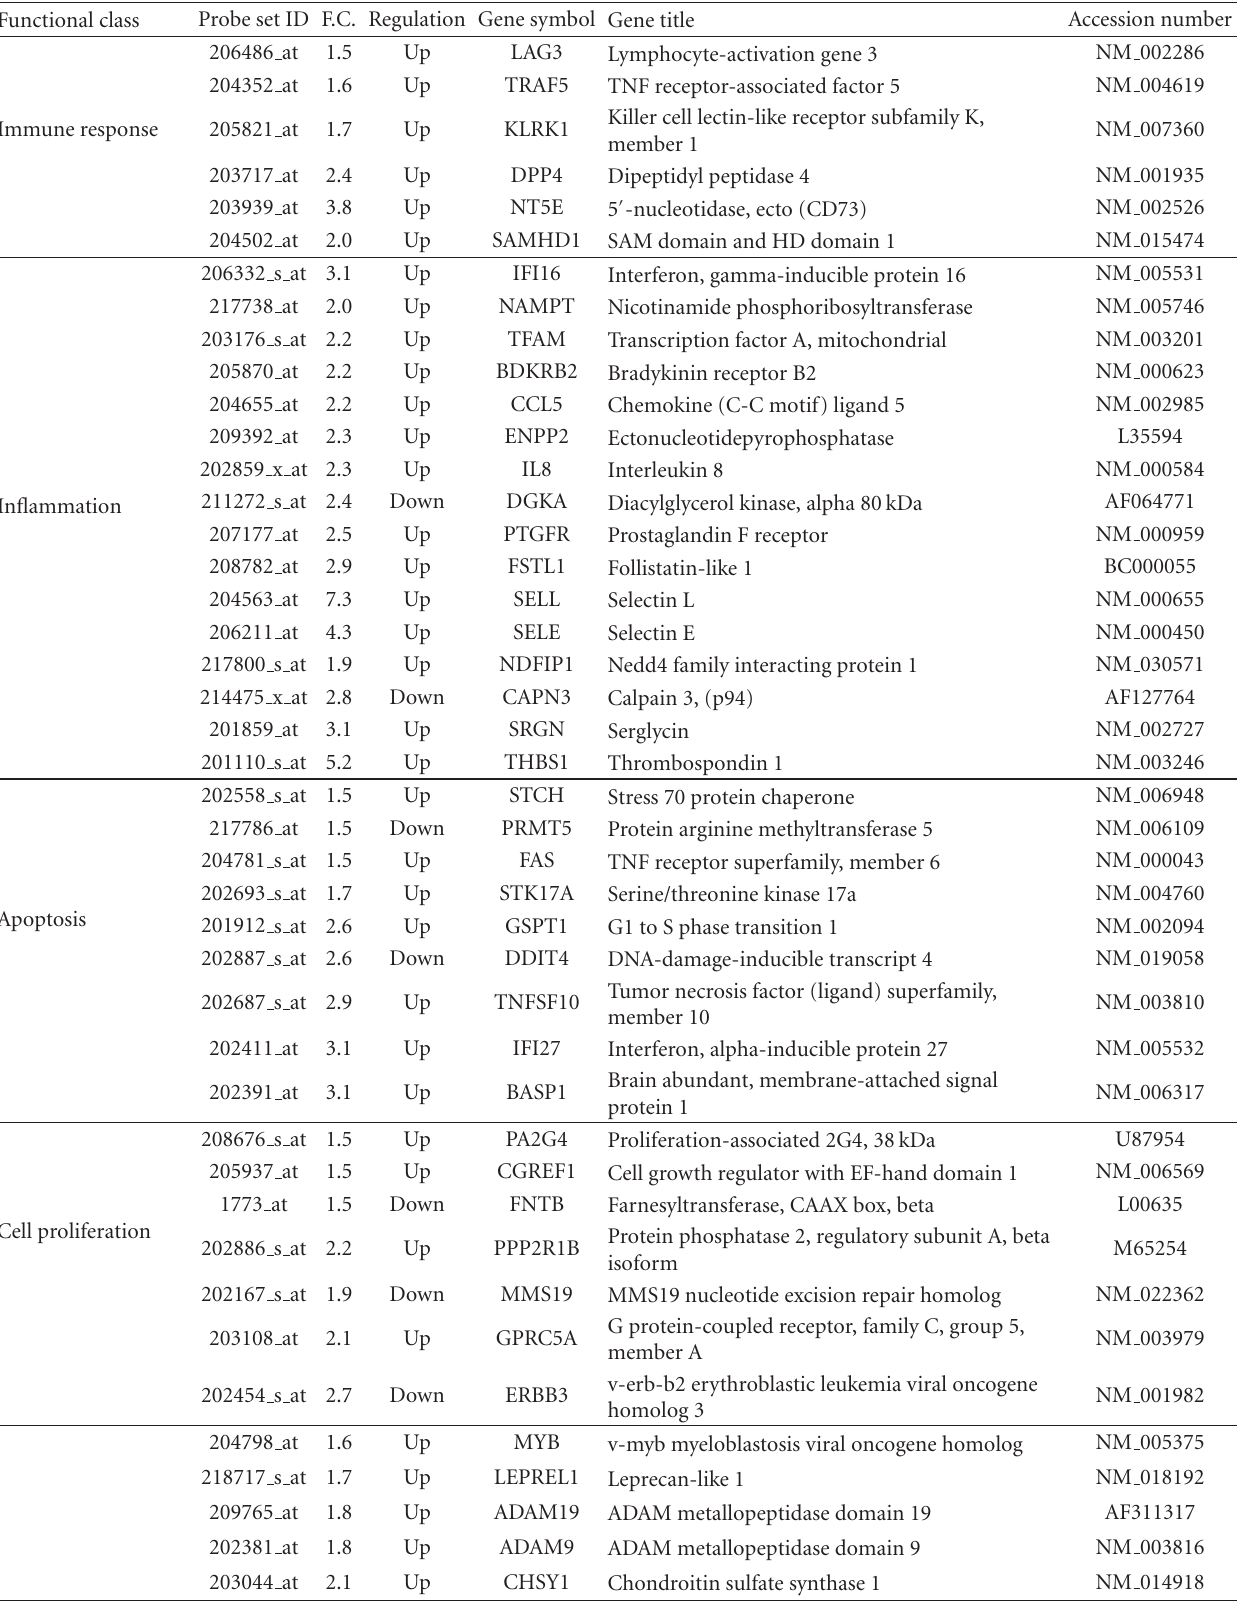
Table 1: Annotated genes di ff erentially expressed in DH versus healthy controls grouped according to their function. Functional